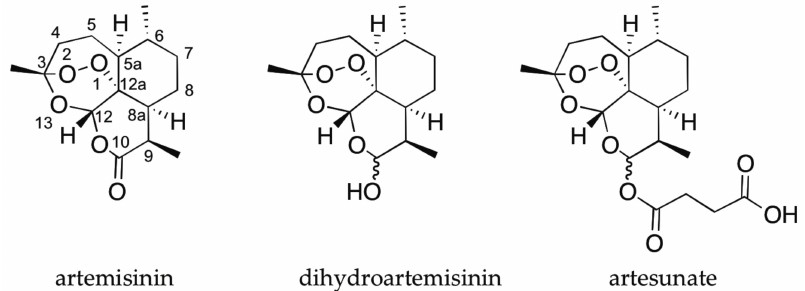
Figure 13. Chemical structures of artemisinin, dihydroartemisinin and artesunate. Reprinted with permission from ref. [58]. Copyright 2020 Royal Society of